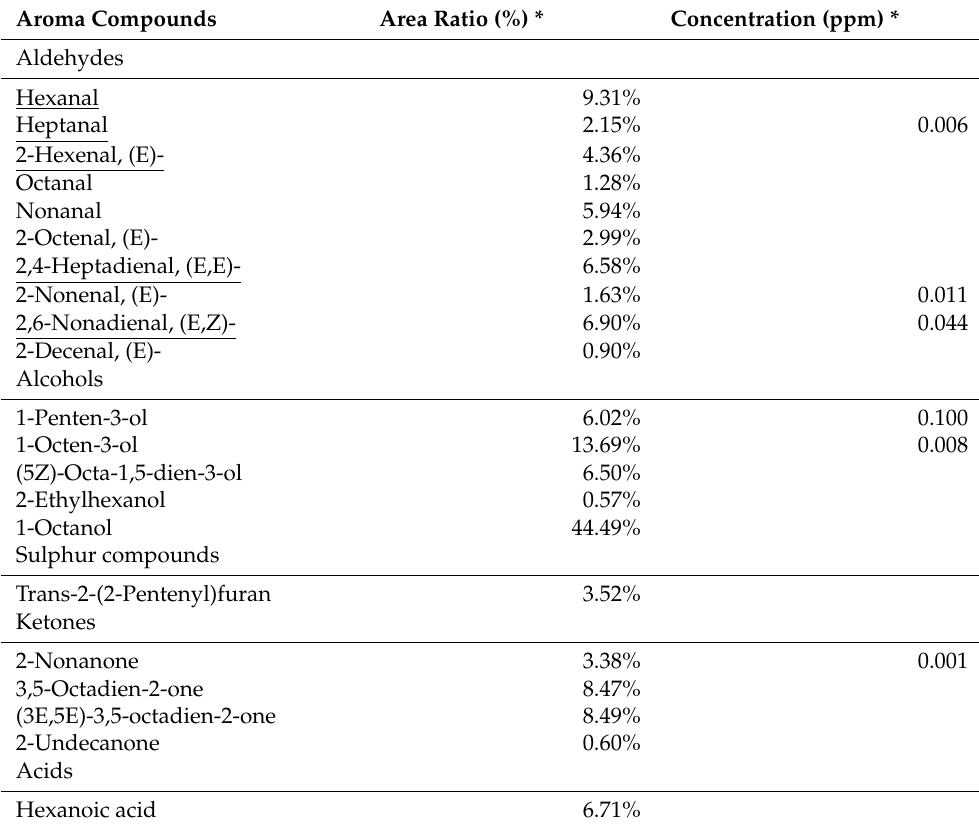
Table 2. Aroma compounds identified in Sardine cooking